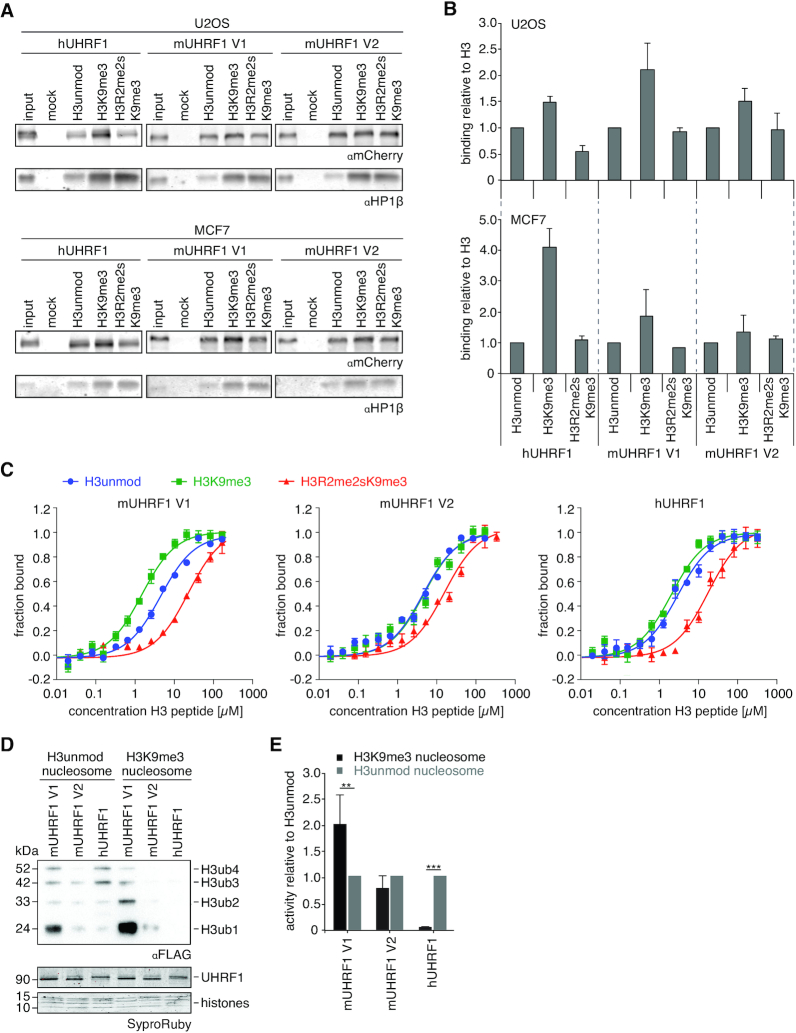
H3K9me3 recognition is dependent on the availability of the TTD. (A) Representative histone-peptide pull-down experiment using extracts from mCherry-hUHRF1 or -mUHRF1 expressing U2OS and MCF7 cells. Material recovered on immobilized peptides was analysed by western blot. HP1β serves as control for a bona fide H3K9me3-binding protein. (B) Quantification of anti-mCherry western blot signals corresponding to the experiments shown in (A) relative to immobilized peptide. Data are presented as mean and s.d. of two (H3R2me2sK9me3) or three (H3 unmodified, H3K9me3) independent experiments. (C) Titration series of different H3 peptides with fluorescently labelled, recombinant UHRF1 proteins were analysed by microscale thermophoresis. Data are plotted as average of three independent experiments; error bars correspond to s.d. (D) Recombinant UHRF1 proteins were subjected to E3 ubiquitin ligase assays using recombinant unmodified or H3K9me3 mononucleosomes. Reactions were analysed by western blotting (top). Signals for UHRF1 and histone proteins on the stained western blot membrane are shown for loading controls (bottom). Running positions of molecular weight markers (left) and different identified proteins (right) are indicated. (E) Quantification of anti-FLAG western blot signals obtained for ubiquitination assays as shown in (D). Absolute values were quantified using ImageJ and normalized to the H3unmod nucleosome signal. Data are presented as mean and s.d. of four (mUHRF1 V1, hUHRF1) and two (mUHRF1 V2) independent experiments. Student's t-test (unpaired, two-tailed) was performed to compare samples; (**) P < 0.01, (***) P < 0.001.